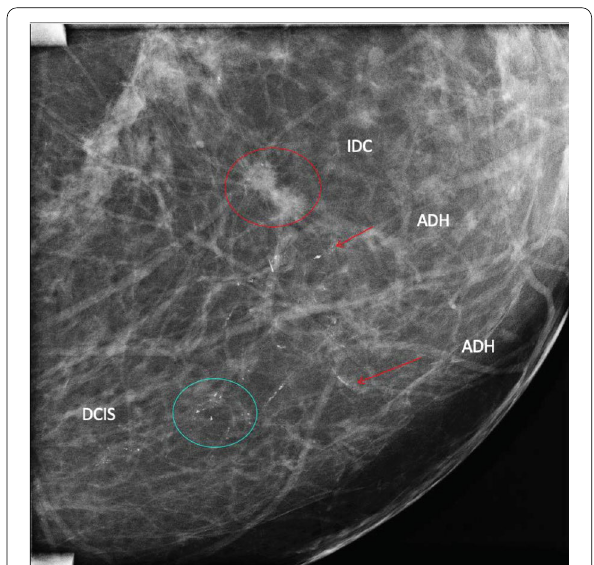
Fig. 2 Digital mammography, lateral view with magnification of the left breast, showing two tiny spiculated masses (invasive ductal carcinoma (IDC)) associated with ductal calcifications (atypical ductal hyperplasia (ADH)) and distant group of pleomorphic calcifications (ductal carcinoma in situ